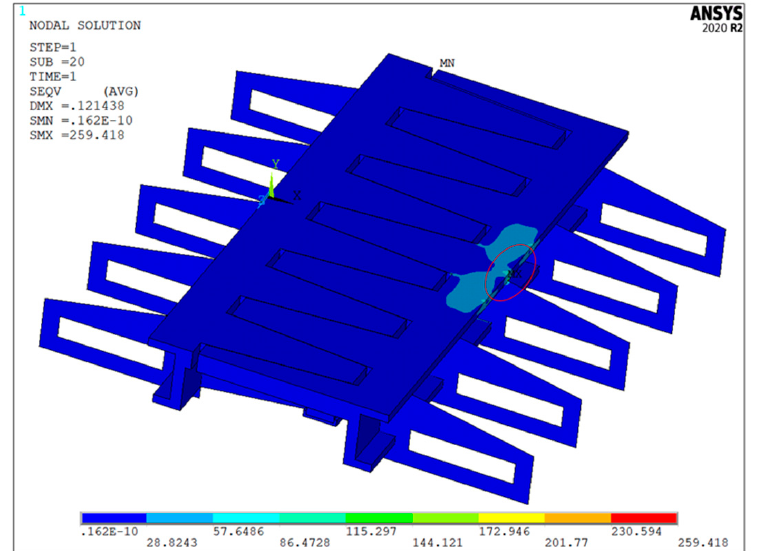
Figure 6. Equivalent stress diagram of the structure under working condition I.